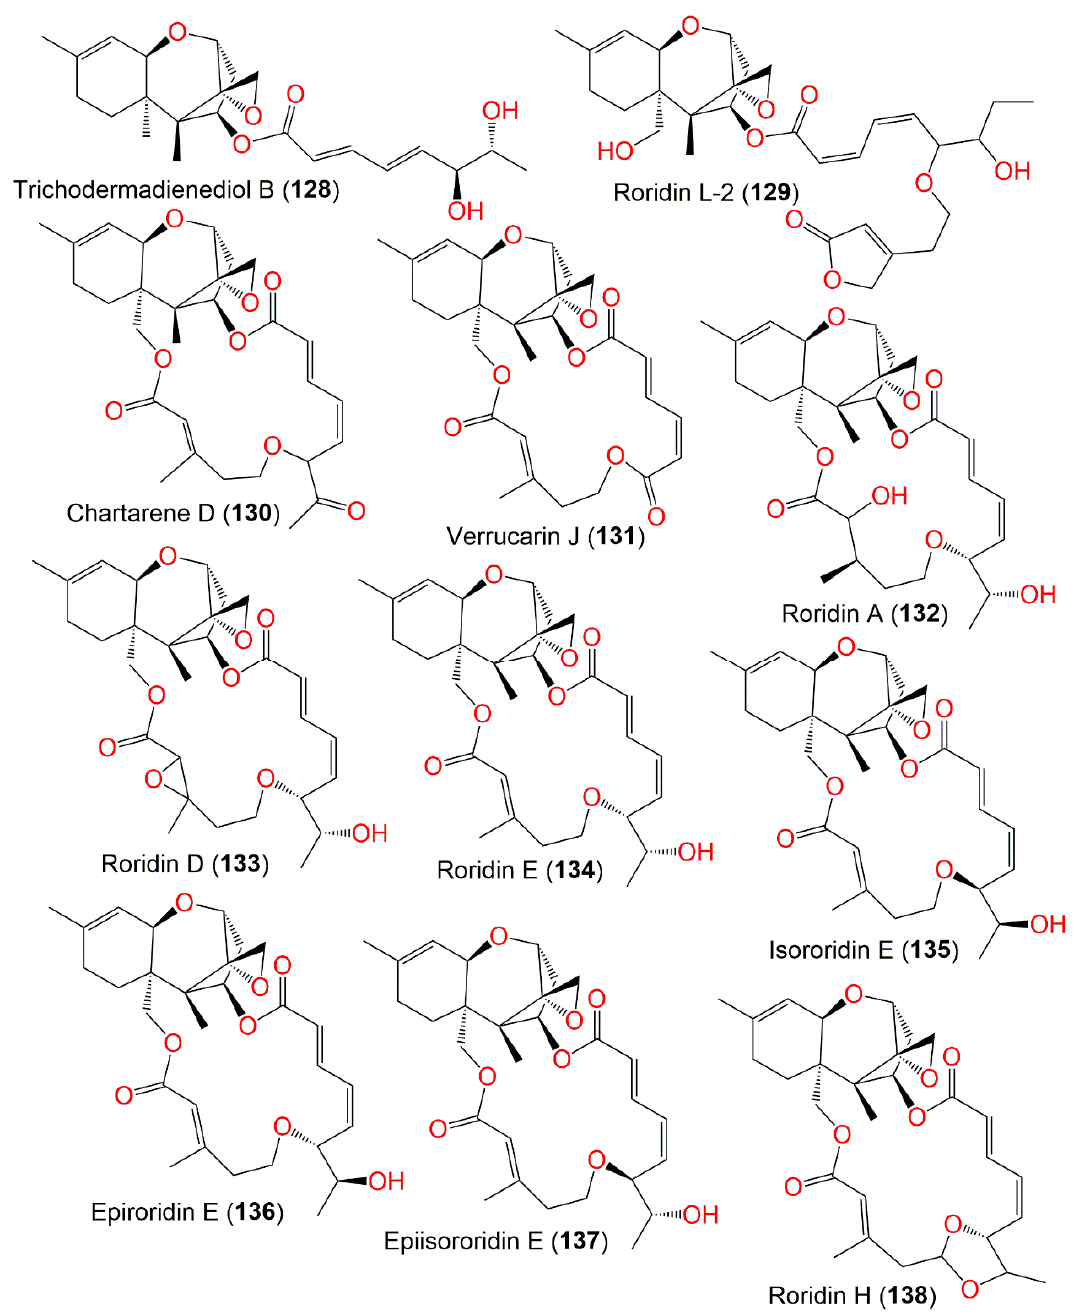
Figure 17. Structures of trichothecenes ( 128 – 138 ) reported from S . chartarum . They were tested versus a panel of human cancer cell lines (e.g., HCT-116, HepG2, BGC-823, NCI-H1655, and A2780) in the MTT method. It is noteworthy that they had se- lective inhibitory influences versus all cell lines with 134, 142 , 144 , and 146 (IC 50 < 10 nM) having potent effectiveness (Figure 18). The structure–activity relation study demon- strated that this effect is related to the scaffolds and substitution pattern.